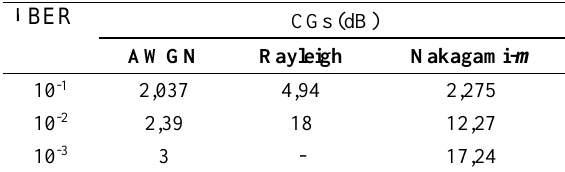
Table 2. CGs for Kasami sequences/LDPC codes